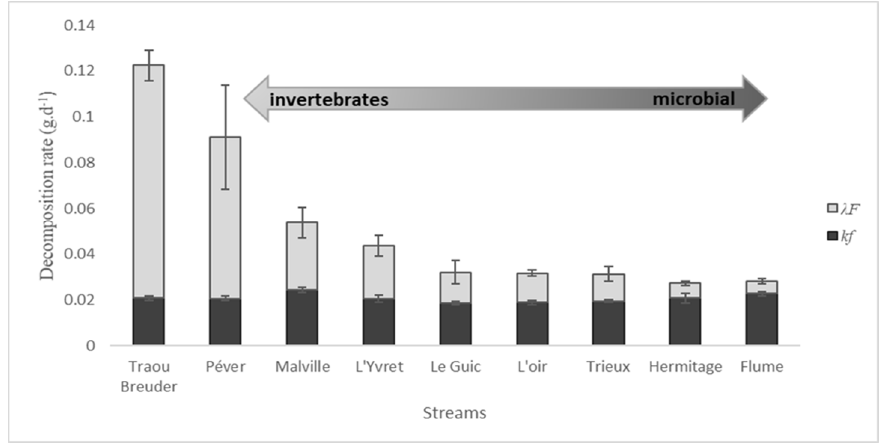
Figure 4. Mean ± SE proportions of kf and λF in total decomposition rate ( kc ). Bars are ordered along the gradient of shredders’ contribution to decomposition rates.